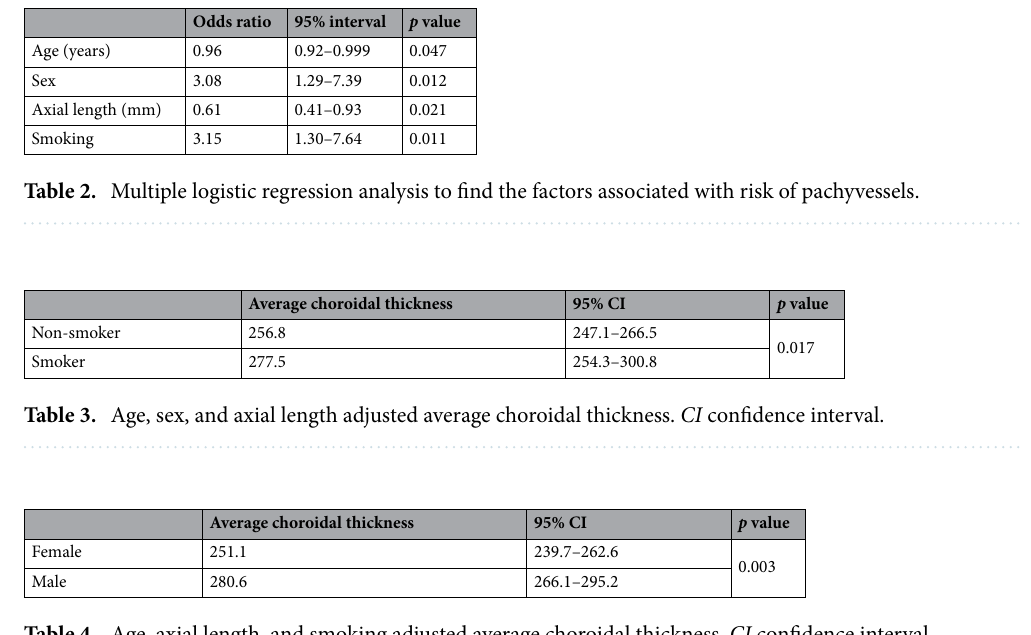
Table 4. Age, axial length, and smoking adjusted average choroidal thickness. CI confidence interval.